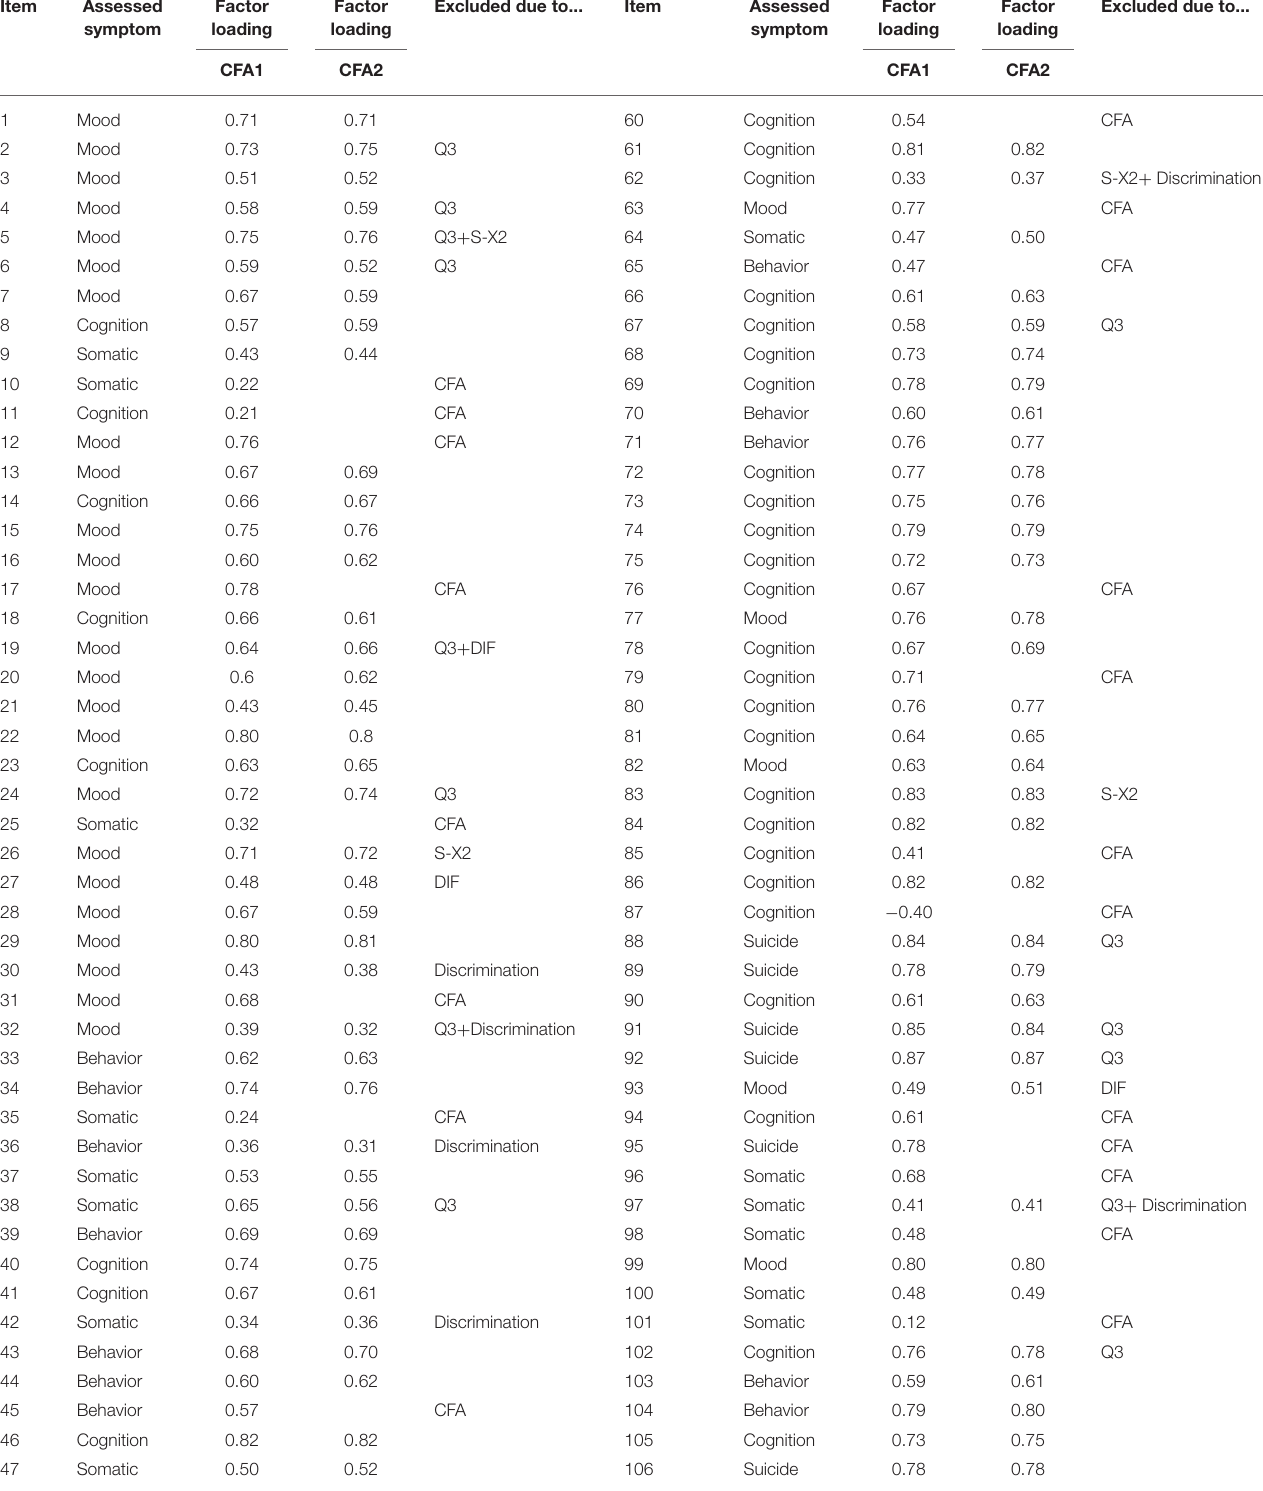
TABLE 2 | Factor loading of the CFA1 and CFA2 and reasons for exclusion.